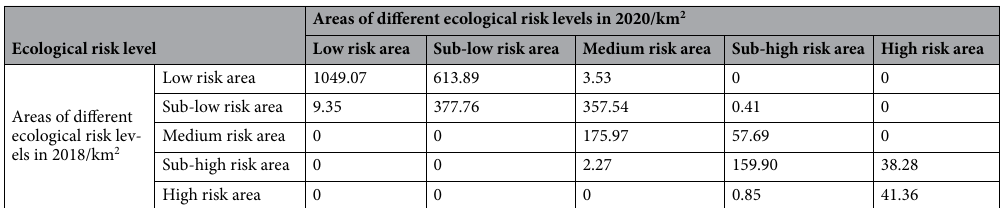
Areas of different ecological risk levels in 2020/km